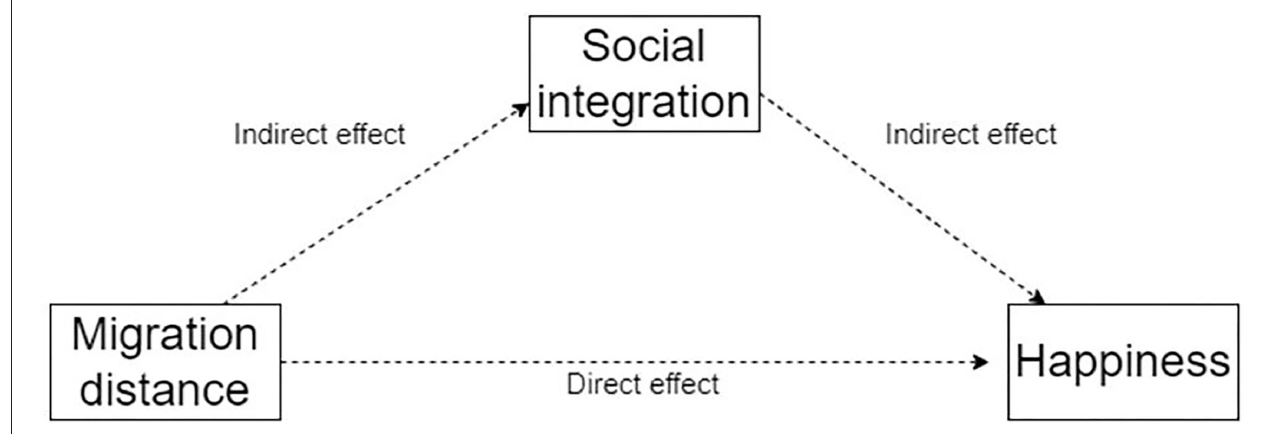
FIGURE 1 | Framework of mediation effect analysis.